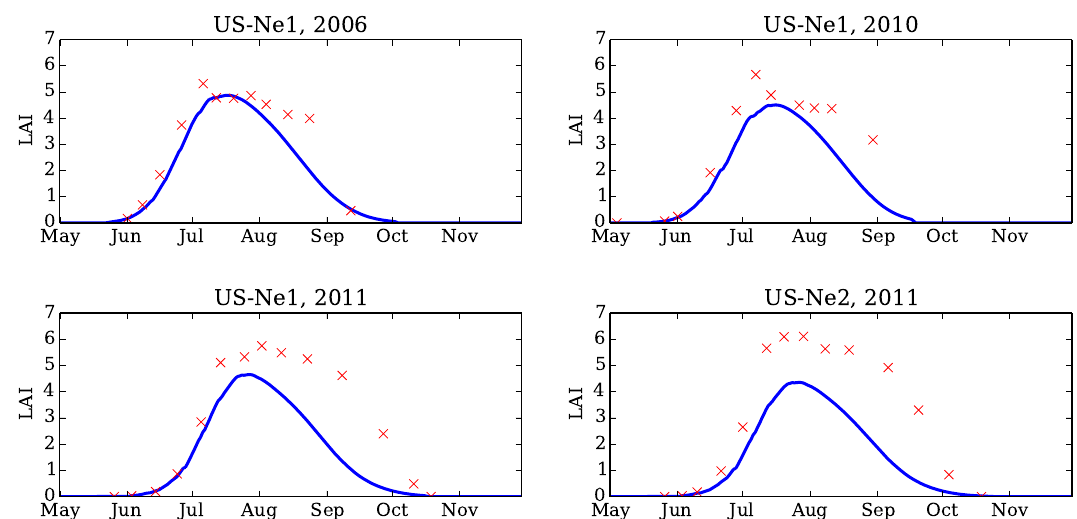
Figure 24. Time series of LAI for irrigated maize at the Mead FLUXNET sites US-Ne1 and US-Ne2; blue: model; red: observations. JULES runs have the crop model switched on and γ = 18 . 0 and δ = − 0 . 45. All other input parameters are as described in Tables 1, 2, 3, and